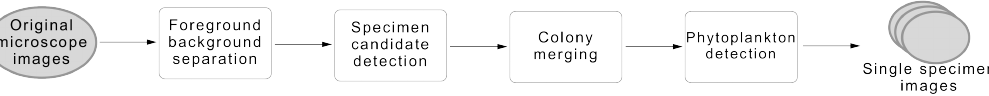
Figure 1. Main steps of the proposed